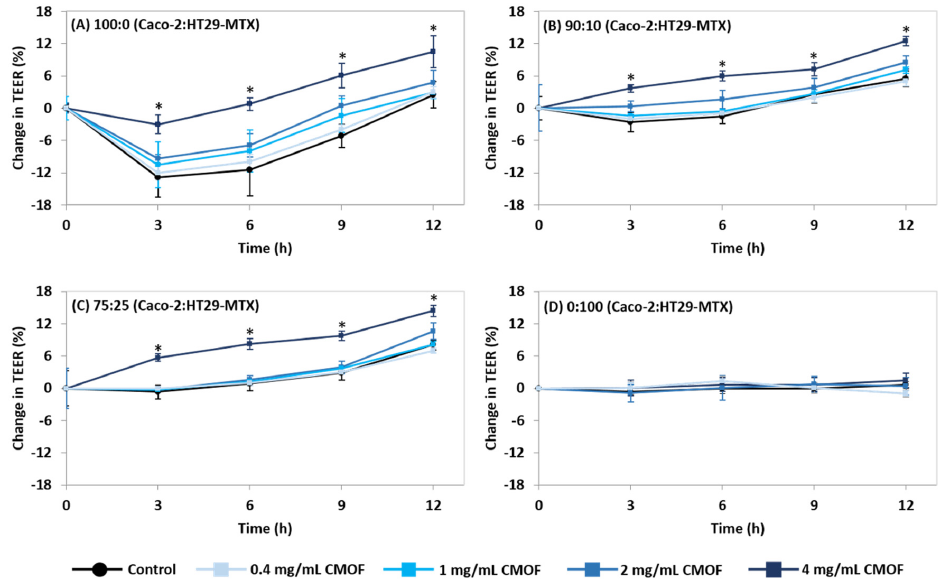
Figure 2. Impact of a caprine milk oligosaccharide ‐ enriched fraction (CMOF) on trans ‐ epithelial electrical resistance (TEER) of post ‐ confluent monolayers over time. The change in TEER as the percentage change compared with initial TEER for ( A ) 100:0, ( B ) 90:10, ( C ) 75:25, and ( D ) 0:100 Caco ‐ 2:HT29 ‐ MTX cultures. Values are means (±SEM) for three experiments (three samples per treatment per experiment). * Significantly different to respective controls p < 0.05 .